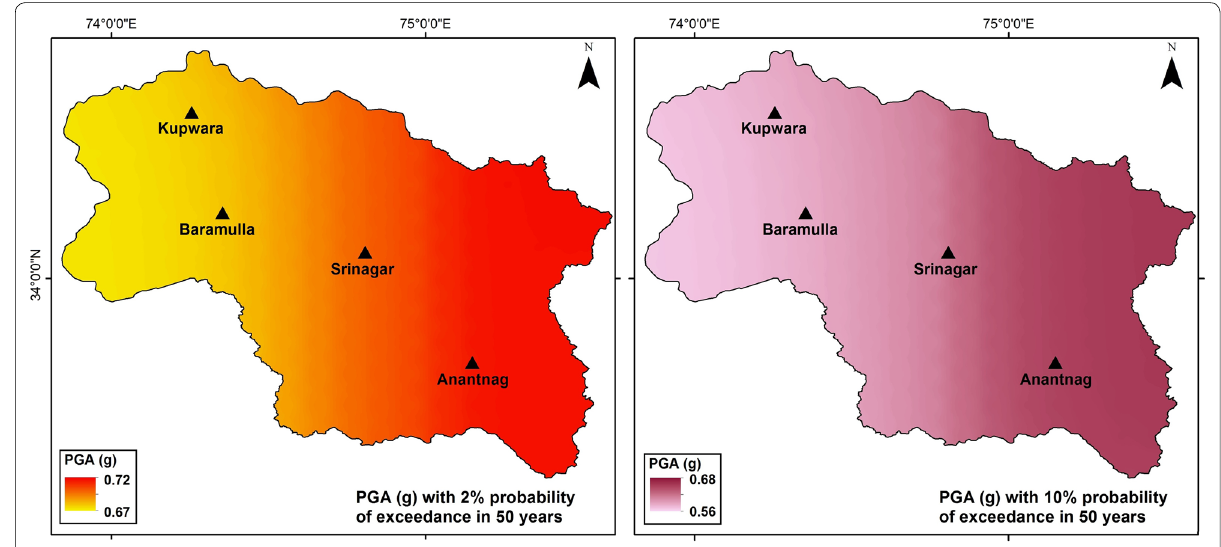
Fig. 6 The seismic hazard maps with faults and seismic source zones as sources, showing predicted peak ground acceleration (PGA) in g with 2% and 10% probability of exceedance within 50 years for engineering bed rock